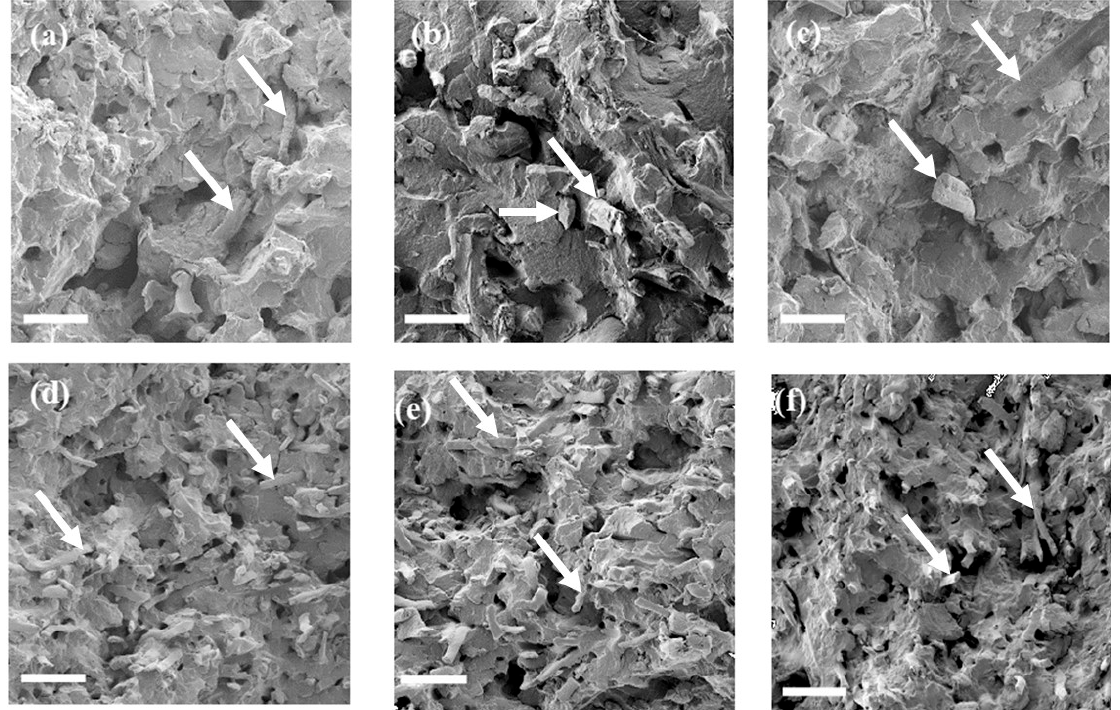
Figure 5. Comparison of pull-out surface between HT TMP and Tencel, from SEM pictures of transverse tensile test specimen fracture area. ( a ) HT TMP only, ( b ) HT TMP + α -NA, ( c ) HT TMP + β -NA, ( d ) Tencel ™ only, ( e ) Tencel ™ + α -NA, ( f ) Tencel ™ + β -NA. Arrows indicate fibres. Scale bar = 100 µm.